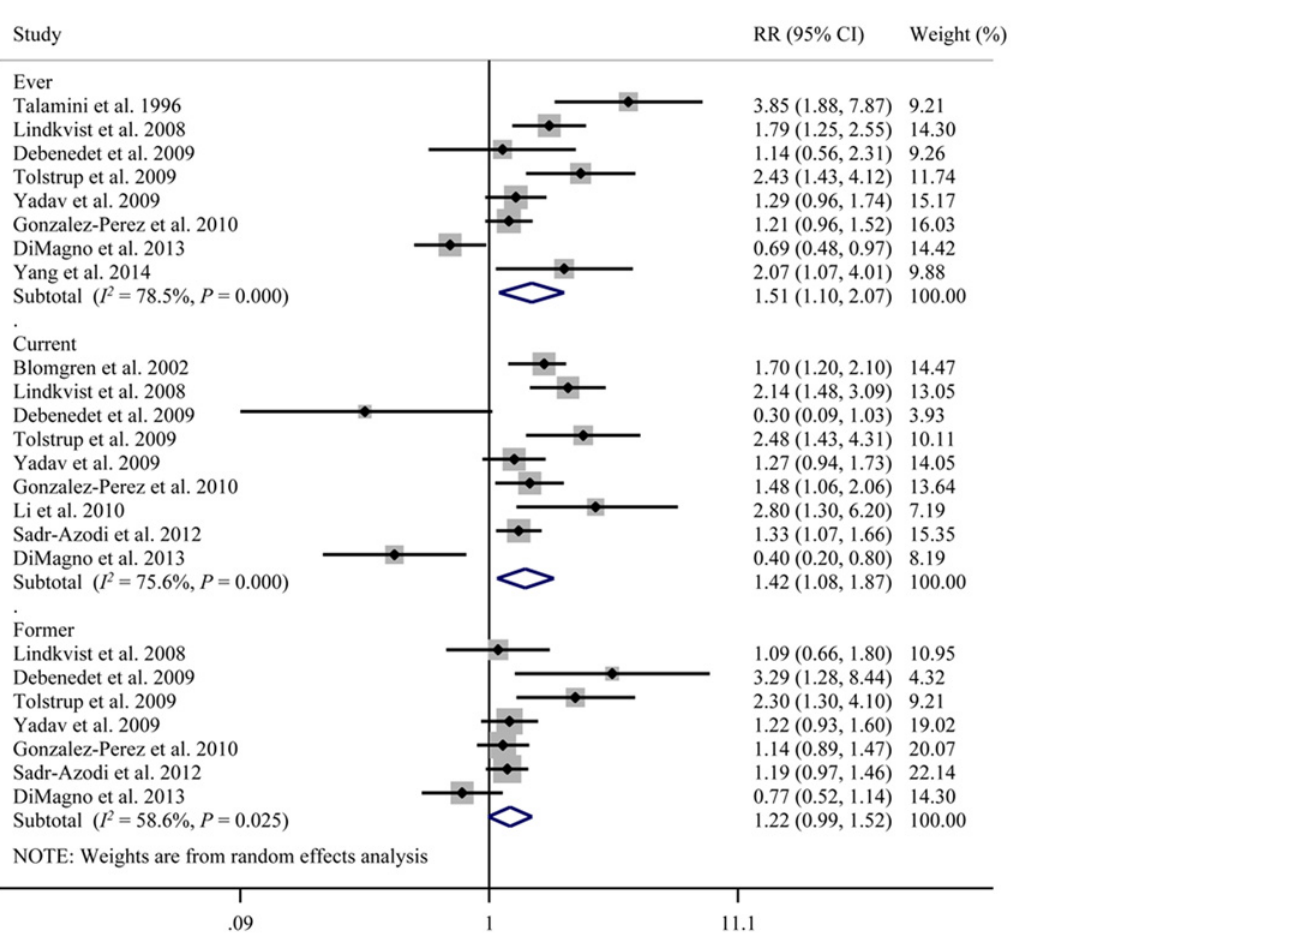
PLOS ONE | DOI:10.1371/journal.pone.0124075 April 16,